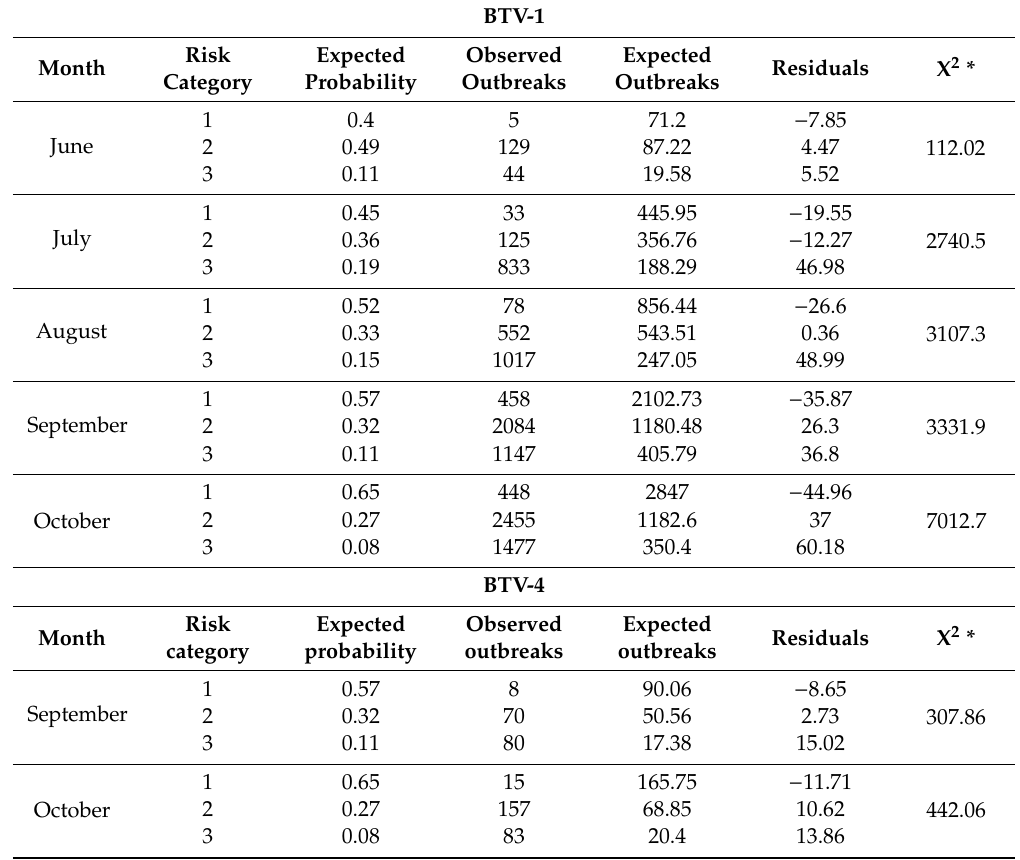
Table 3. Statistical analysis of the di ff erence between the observed BTV outbreaks and the number of expected BTV outbreaks calculated from the expected probability, which is based on the number of cells per each risk